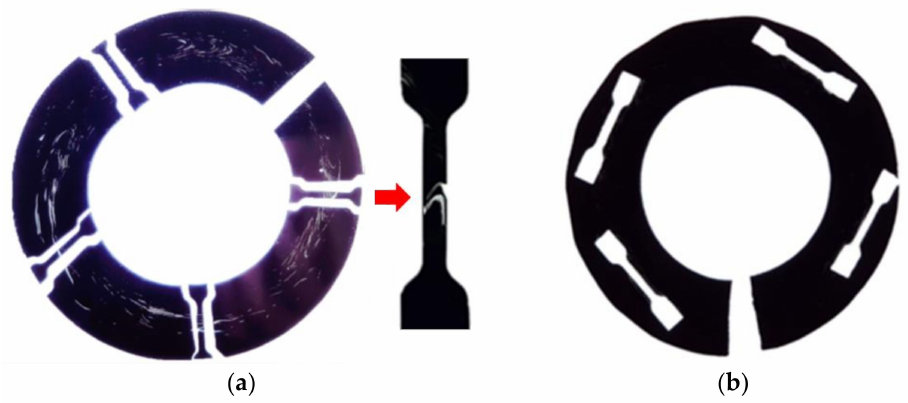
Figure 4. Sampling location of micro-tensile specimens. From ( a ) sample 4 and ( b ) sample